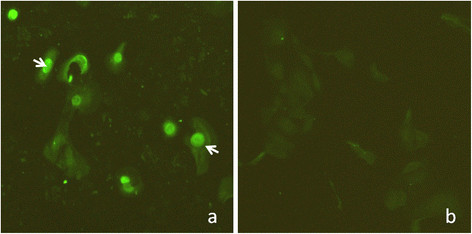
Identification of specificity of mouse antibodies in PK15 cells infected with PCV2 by immunofluorescent microcopy. (a) PK15 cells were infected with PCV2 at 10-4.3 TCID50 for 72 h, and then incubated with mouse antibody to PCV2 GST-ORF2-E. (b) Non-infected PK15 cells were used as a negative control.